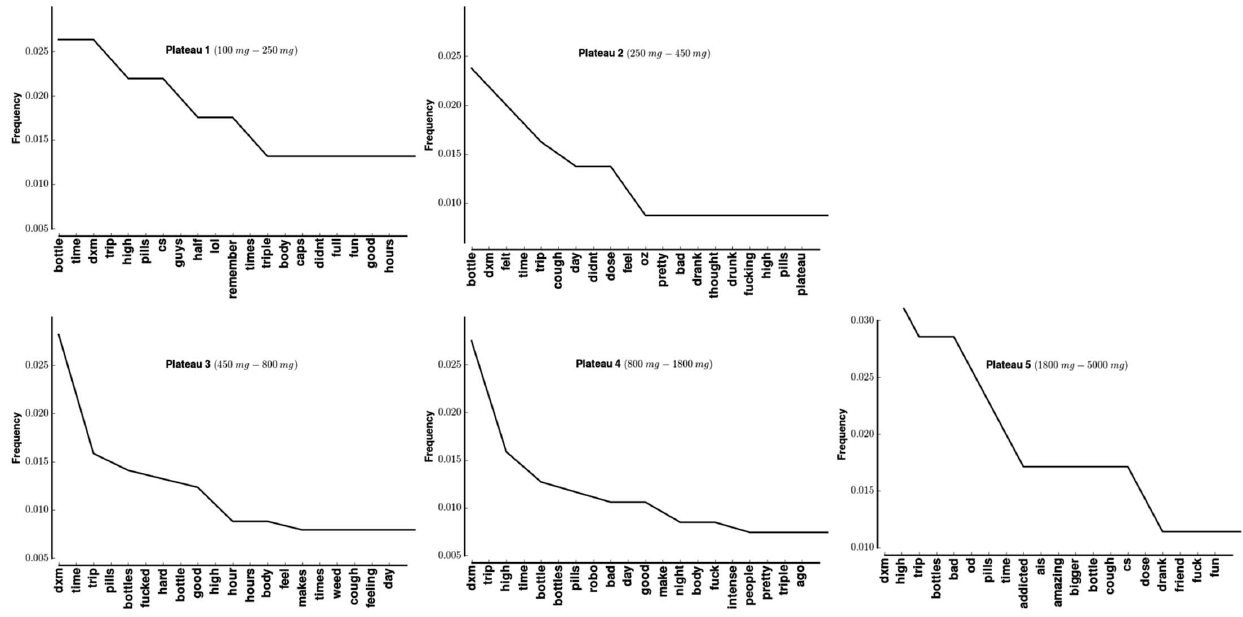
Figure 8. Most frequent words in YouTube comments stratified by plateau. doi:10.1371/journal.pone.0082452.g008 PLOS ONE |